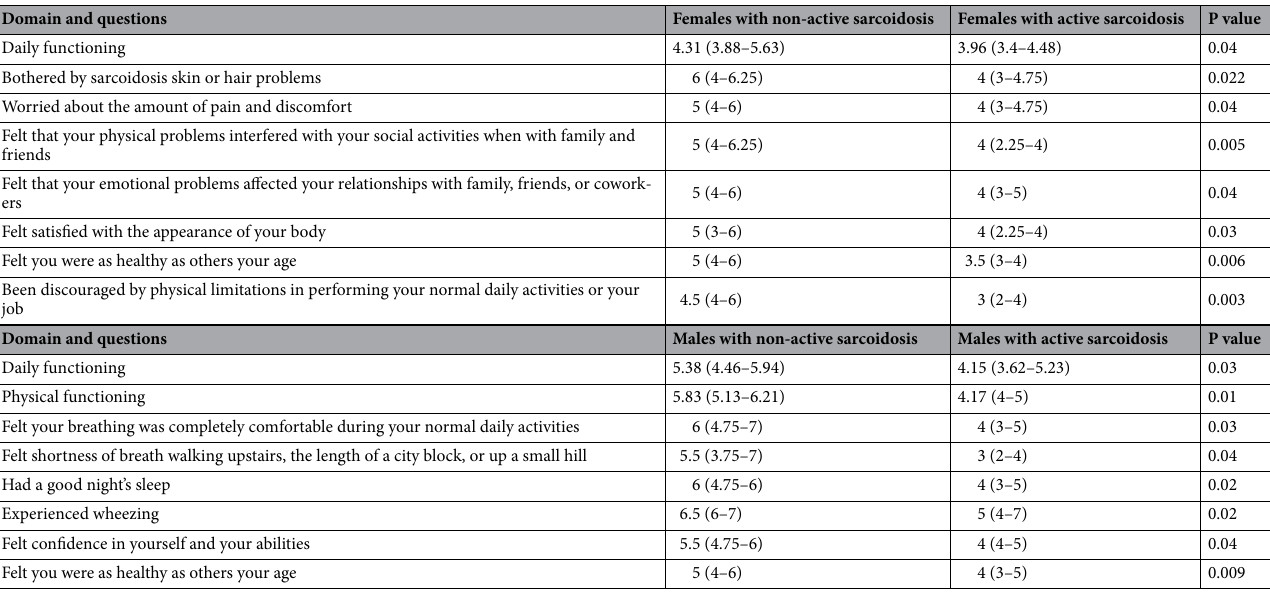
Table 5. Sex differences in active sarcoidosis. Data are presented as median (IQR). Presented P values are for Wilcoxon rank sum